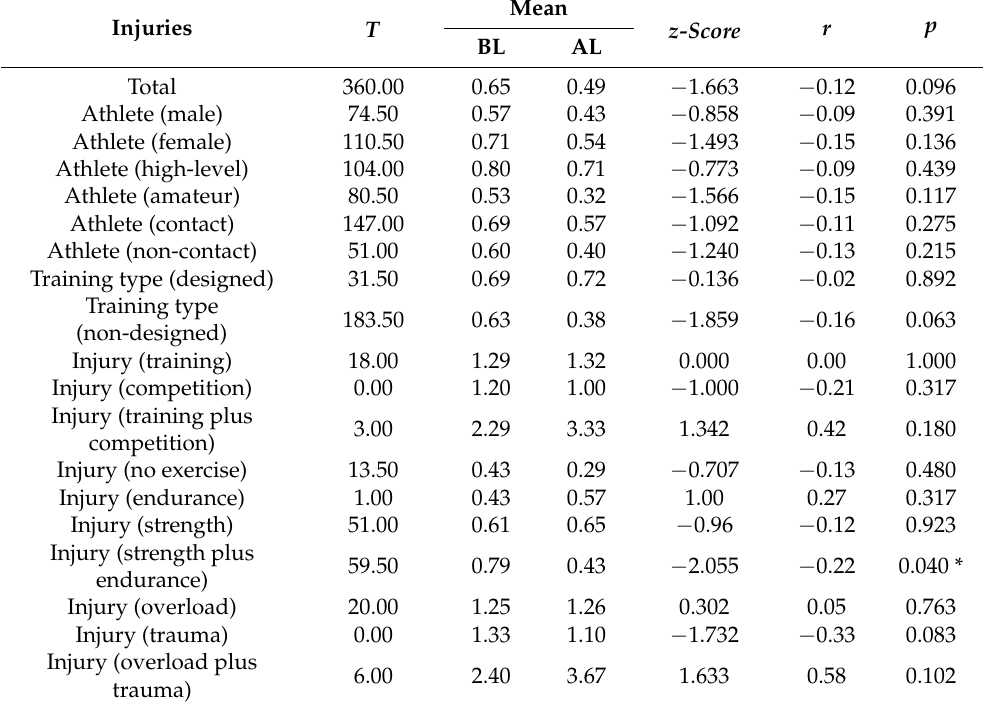
Table 6. Comparison of differences in the IRs for the examined variables between BL and AL